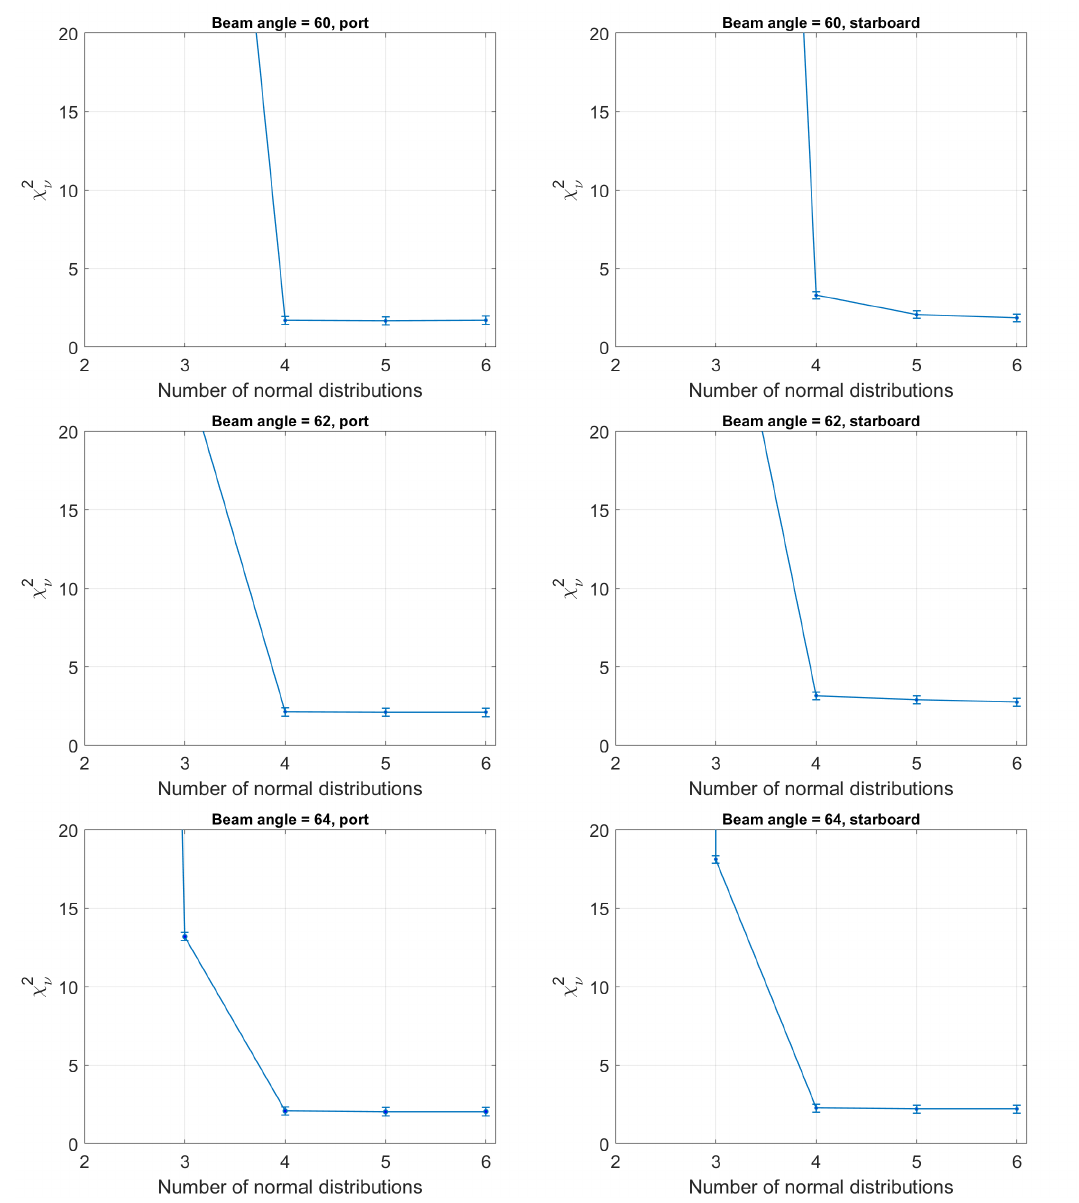
Figure 5. Reduced chi-square as a function of number m of Gaussians. Error bars, which were multiplied by a factor of 2 for distinction, indicate standard deviation of reduced chi-square test